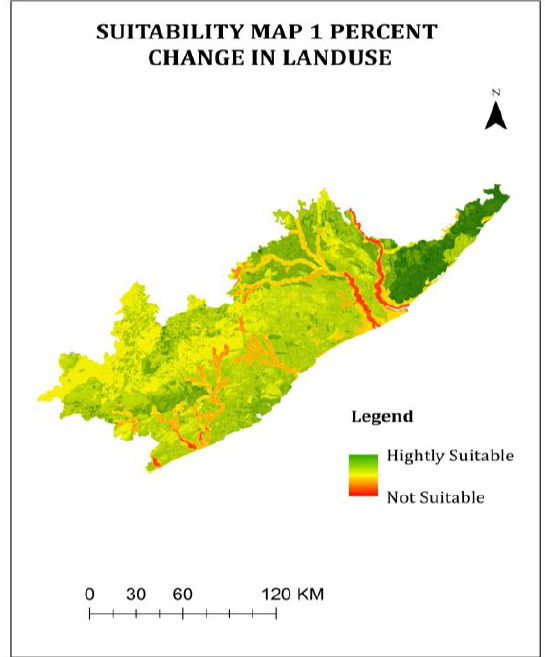
Fig 9: Suitability map with 1 percent change